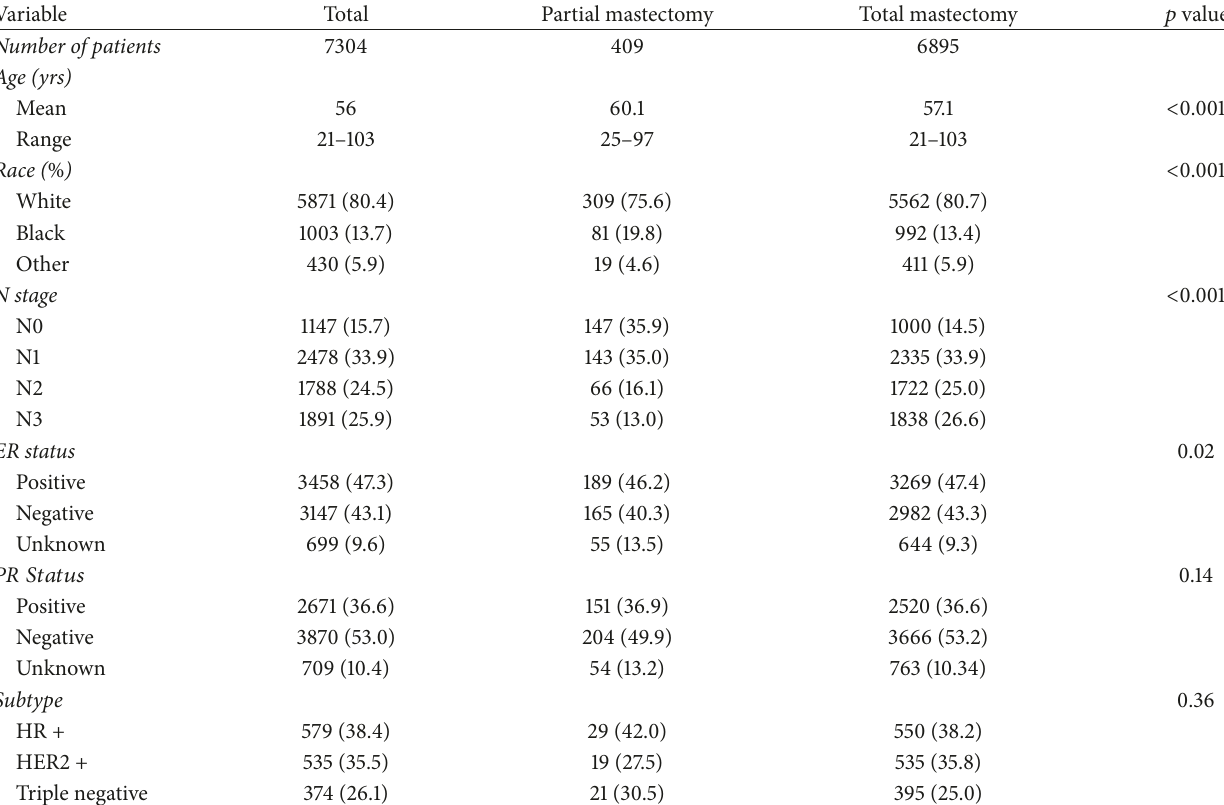
Figure 2: Kaplan-Meier survival curves for patients stratified by type of surgery ((a), 𝑝 = 0.003 ) and treatment with radiation ((b), 𝑝 < 0.001 ). Table 1: Study population